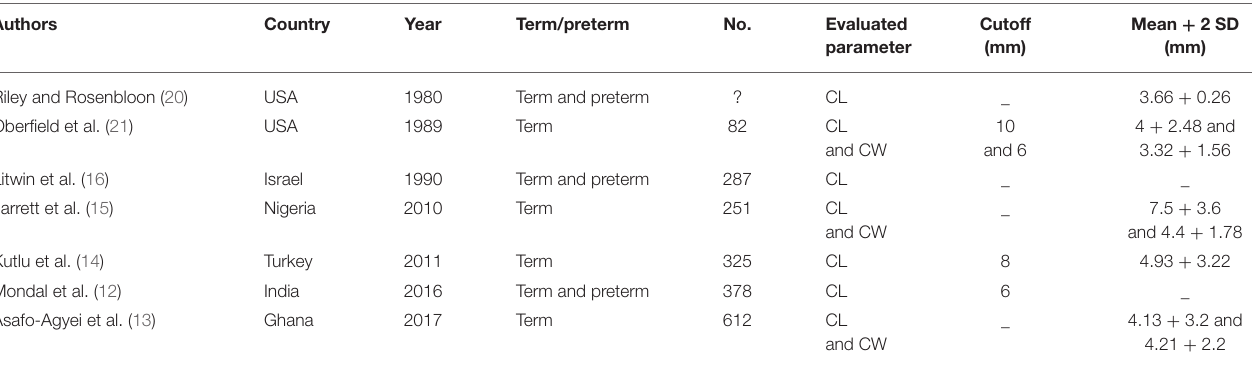
TABLE 2 | Studies investigating